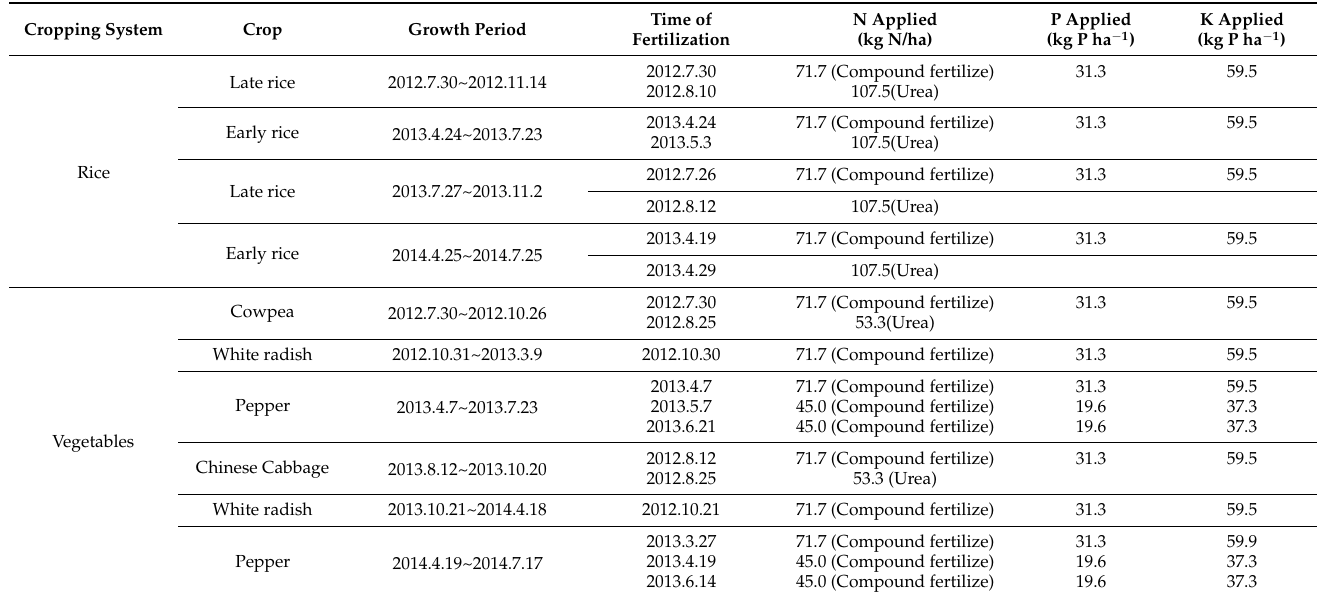
Table 1. The main management practices used for rice and vegetables cropping system from 2012 to 2014.